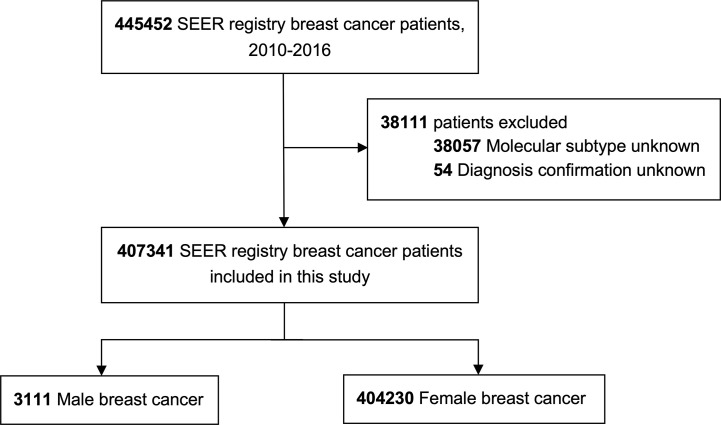
The flowchart of information processing and patient selection.